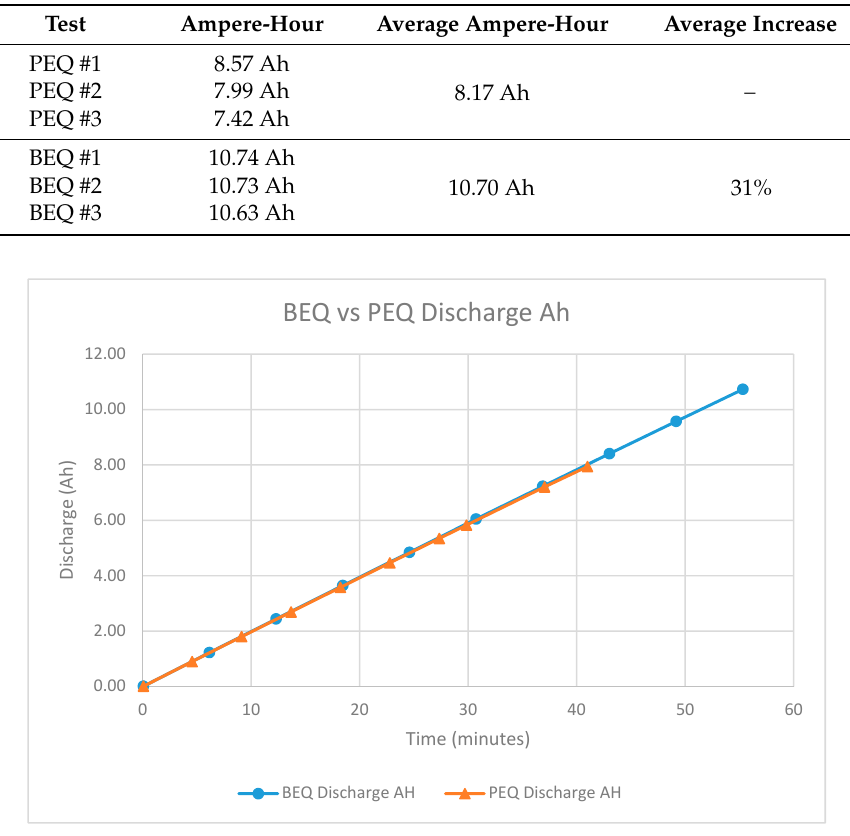
Figure 10. Discharging Ah vs. Time for the BEQ and PEQ with 23 GAIA cells and 1 Boston Power cell.